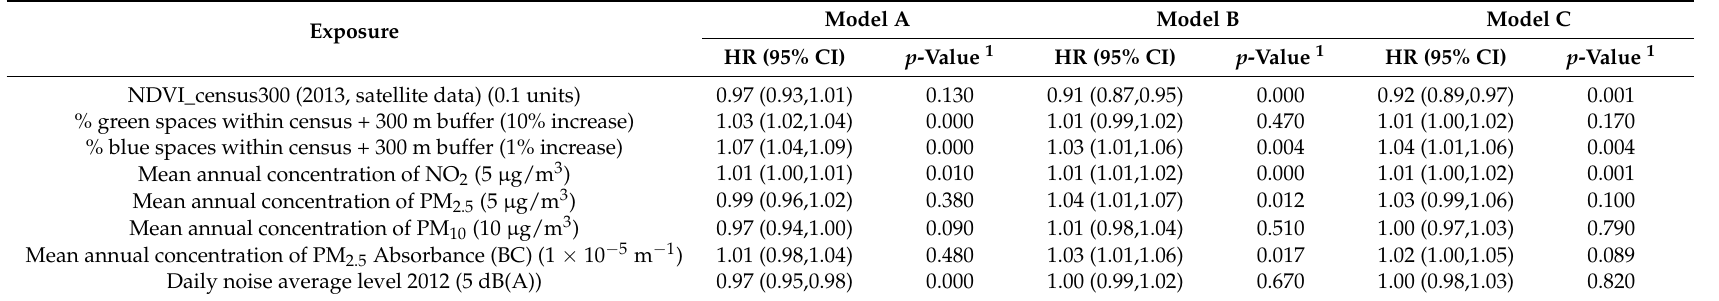
Table 4. Models of single pollutants (PM 2.5 , NVDI, GS, BS, Noise) in Barcelona ( n = 792,649). Exposure